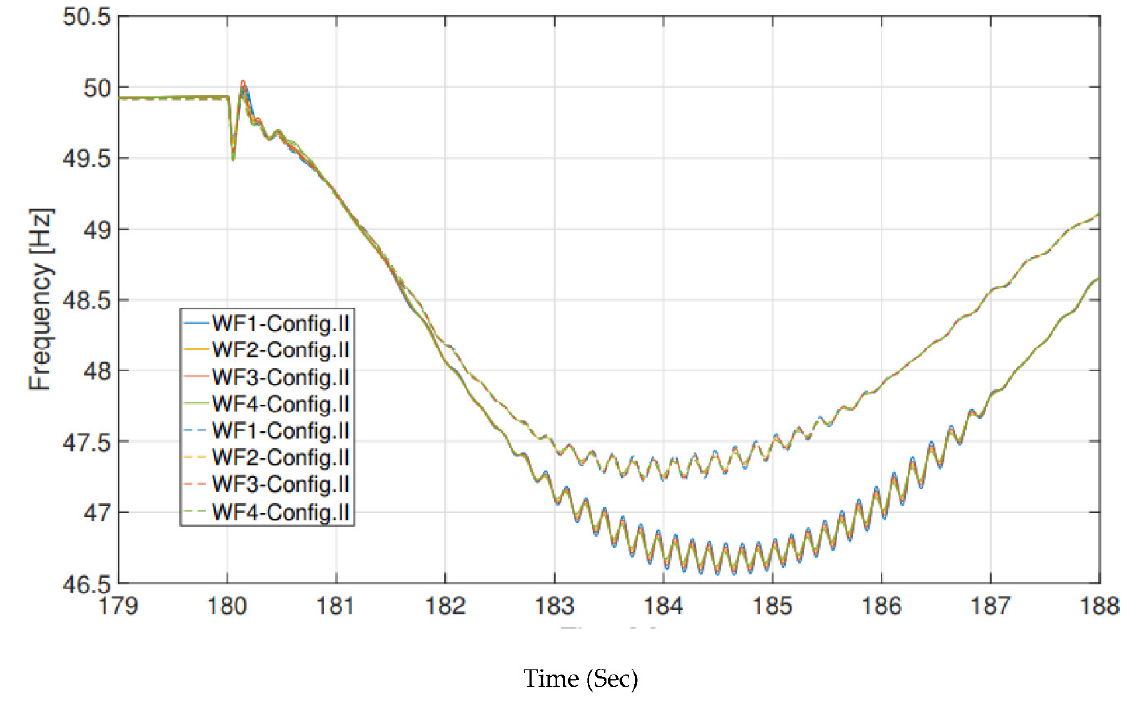
Figure 16. IEEE bus 39 frequency vs. time.